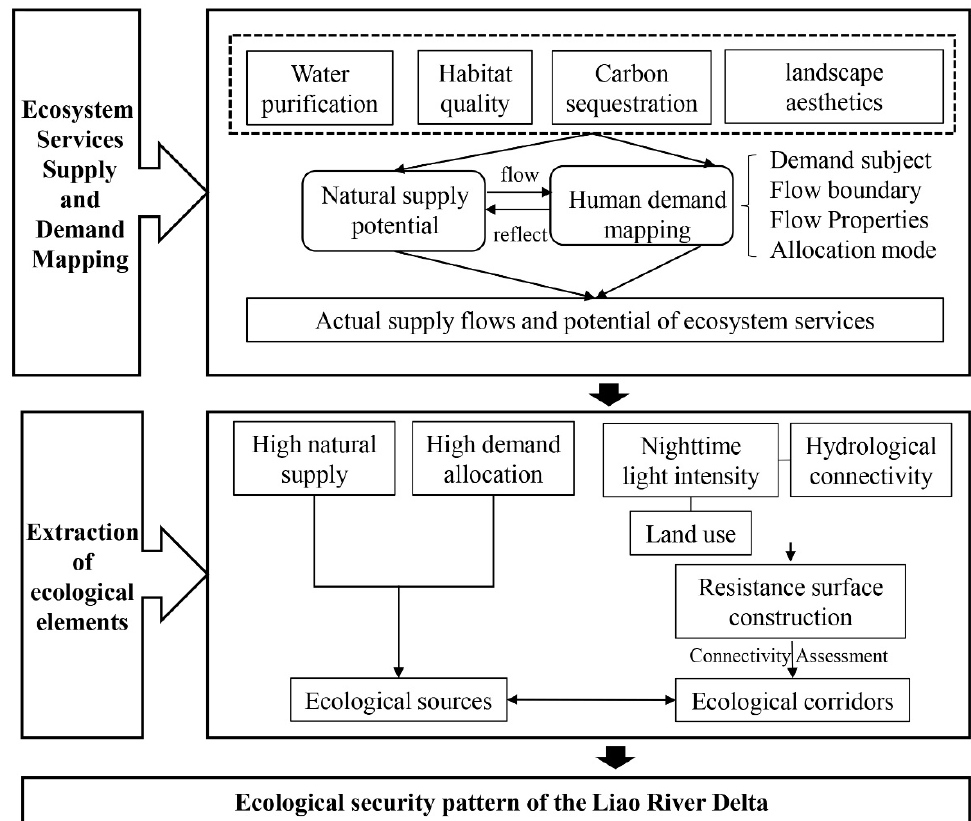
Figure 2. The conceptual framework for ecological security pattern.